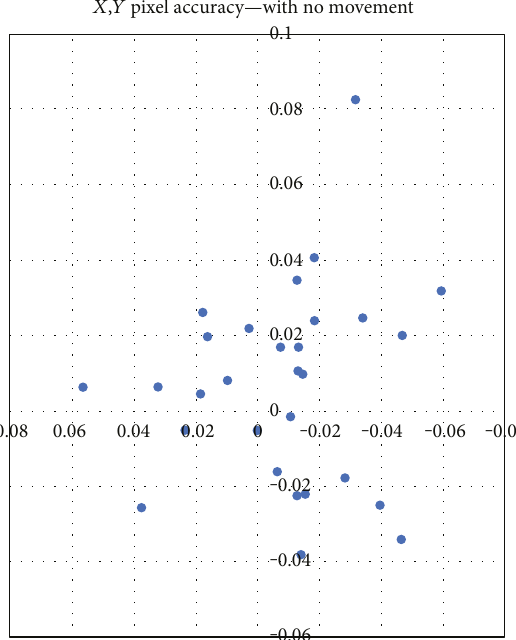
Figure 14: The typical noise of level images of the same targets, they were shot with the same lighting and camera parameters. The typical noise level is about 0.03 – 0.04 pixel. In almost all tested cases, the level below 0 . 1 pixel.